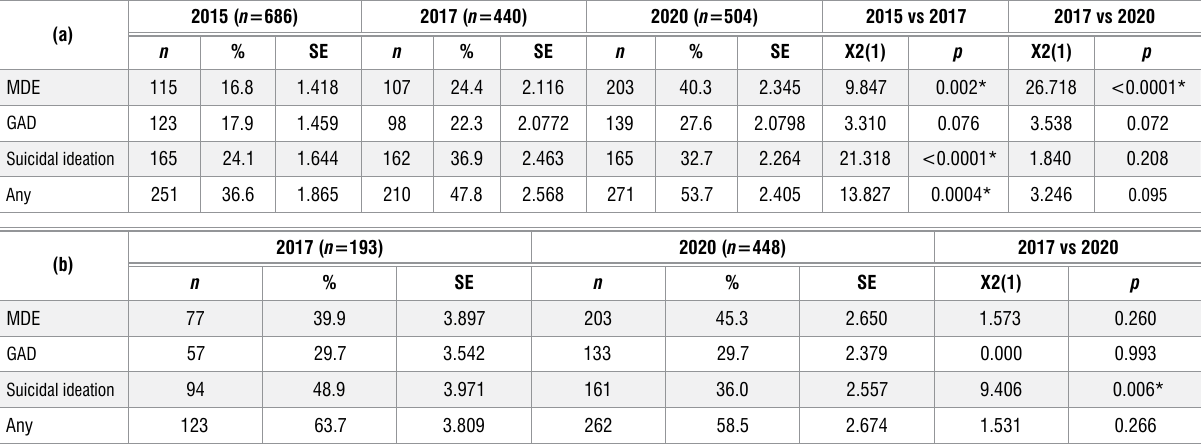
12-Month prevalence of major depressive episode (MDE), generalised anxiety disorder (GAD) and suicidal ideation among the total sample of